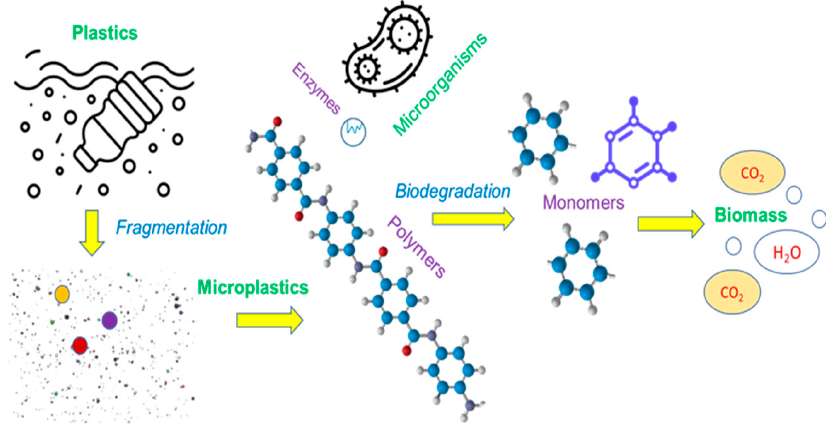
Figure 2. Bioplastic degradation in the aquatic